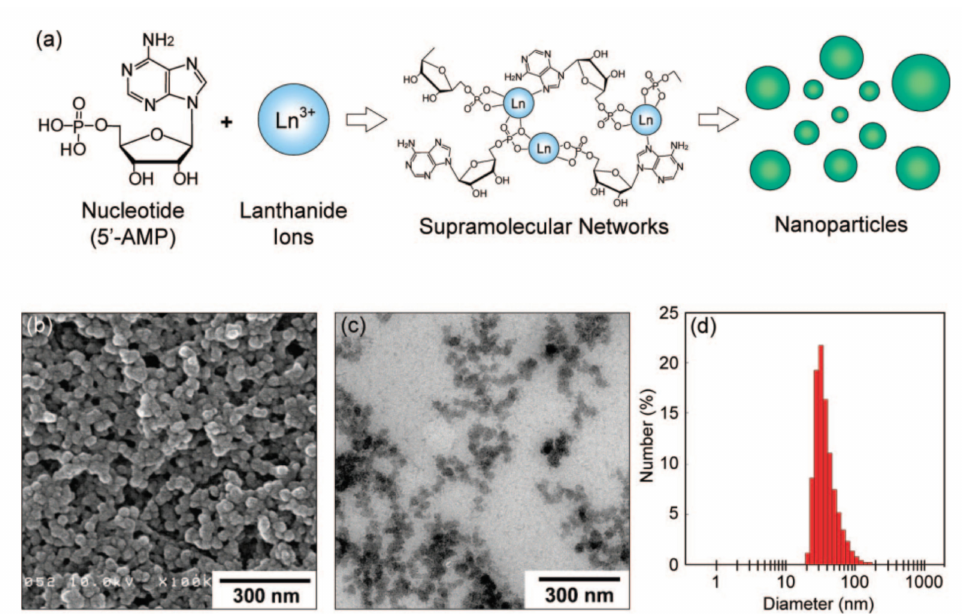
Figure 10. ( a ) A schematic illustration of nanoparticle formation through the self-assembly of 5 (cid:48) - AMP (5 (cid:48) -adenosinemonophosphate) and Gd 3+ ions. ( b ) SEM image of 5 (cid:48) -AMP/Gd 3+ nanoparticles prepared in water. ( c ) TEM image of 5 (cid:48) -AMP/Gd 3+ nanoparticles dispersed in aqueous poly(sodium 4-styrene sulfonate). ( d ) Size distribution histogram obtained by dynamic light scattering (DLS) measurement. Reproduced from Ref. [97] with permission from the American Chemical